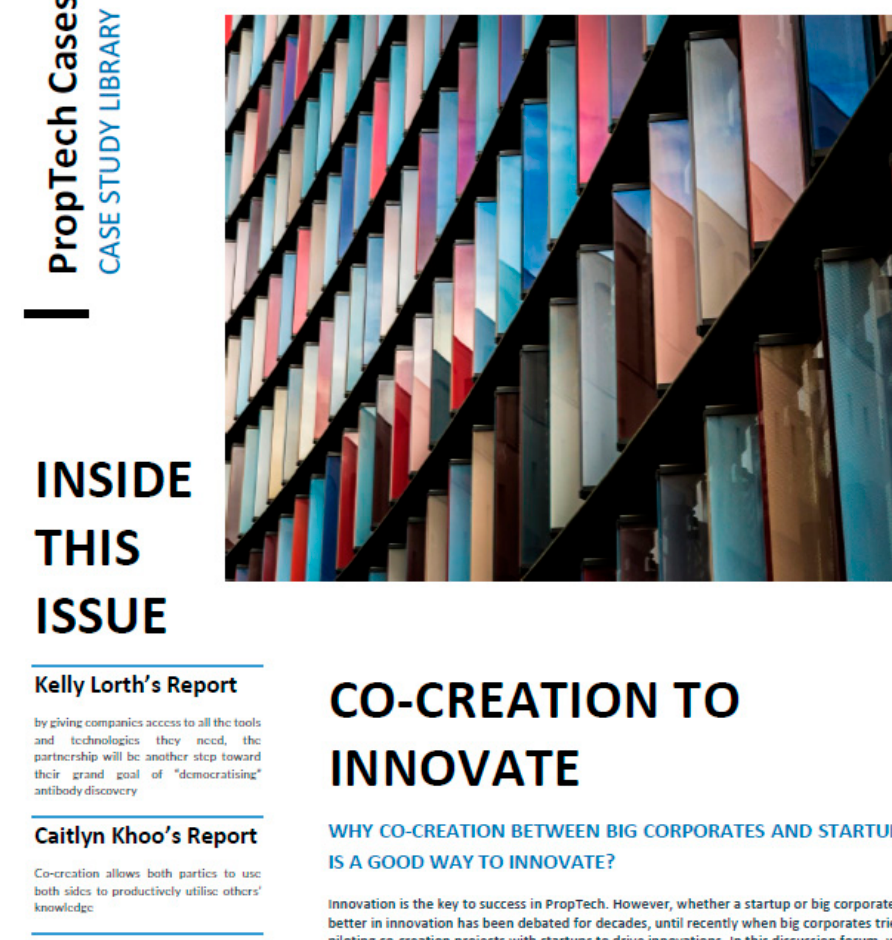
Figure 3. A PropTech Case on Co-creation to Innovate. Source: the author’s blog page at https://ecyy.medium.com/co-creation-to-innovate-a-case-study-b5331611d579 (accessed on 2 Feb- ruary 2023).